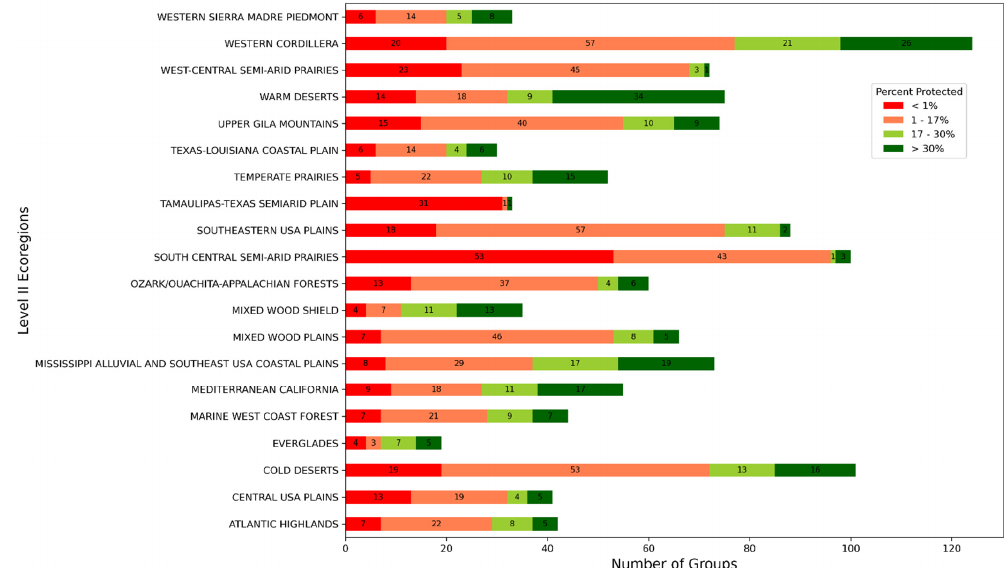
Figure 6. Number of natural United States National Vegetation Classification Groups within one of four categories of representation within Status 1 and 2 lands by Ecoregion, For example, the Western Sierra Madre Piedmont Ecoregion had a total of 33 Groups that had been mapped within the ecoregion, of those 6 Groups had less than 1% of the mapped distribution in Status 1 and 2 Lands and 8 Groups had greater than 30% of their distribution in status 1 and 2 lands.